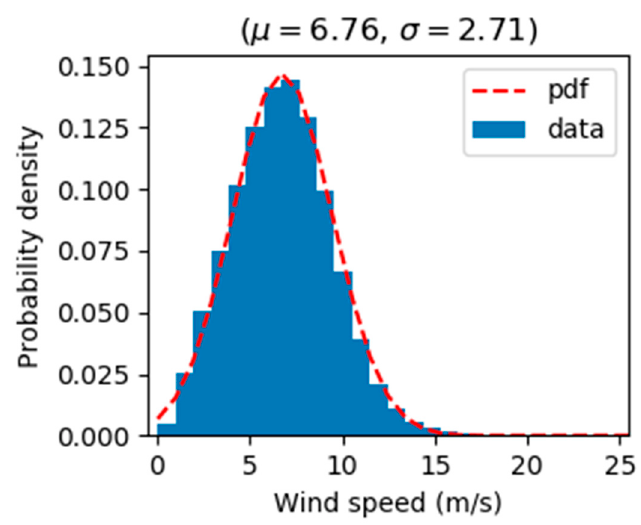
Figure 13. CCMP reference wind speed probability density distribution in the training samples. Remote Sens. 2019 , 11 , x FOR PEER REVIEW 15 of 18